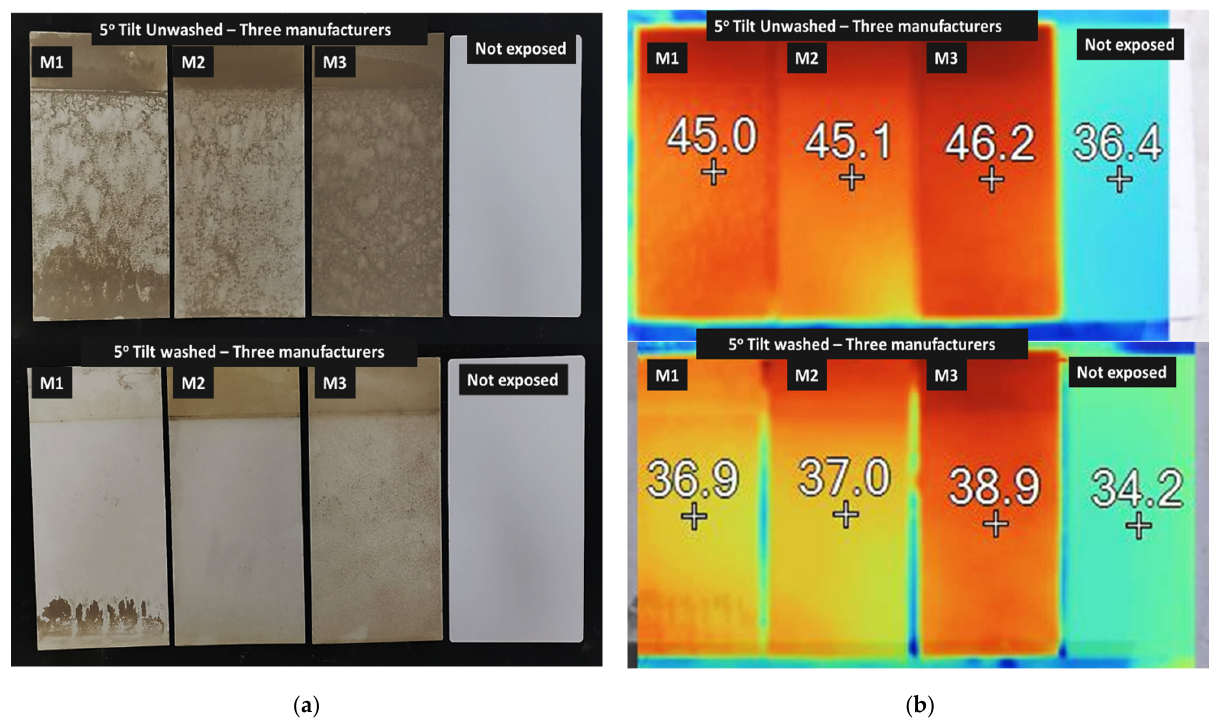
Figure 12. Unwashed and washed visible ( a ) and infrared ( b ) images of the three selected samples.